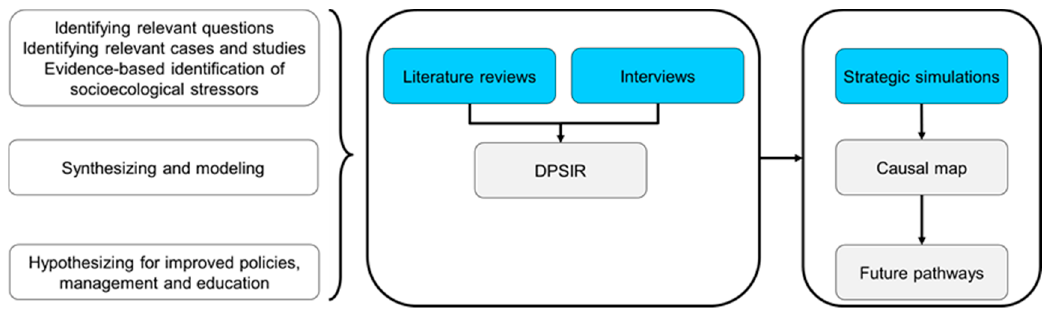
Figure 1. Multiple lines of evidence. This figure describes our approach of multiple lines identification of socio-ecological stressors in Burkina Faso’s aquatic ecosystem. The Drivers–Pressure–State–Impact–Response (DPSIR) serves as the analytical framework shaping this research. The different research steps are displayed on the left side. The different methods or lines of evidence are highlighted in blue and the outcomes in grey. Literature reviews and interviews were used to elaborate a DPSIR model. This contributed as a background to the strategic simulations that yielded a causal map, and future pathways toward sustainable aquatic ecosystems and fisheries.